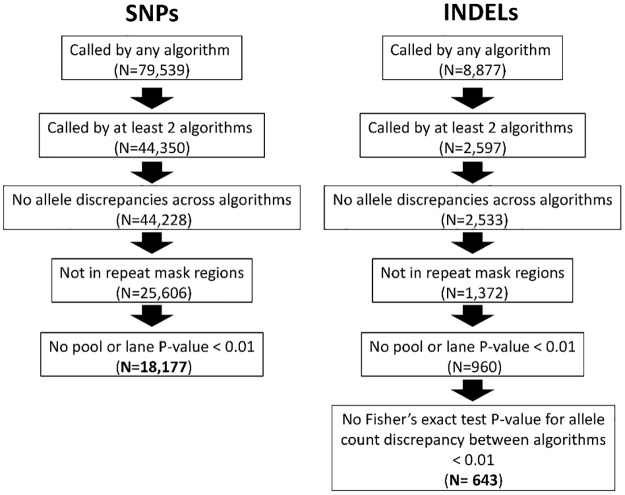
Flow chart of the variant selection process.